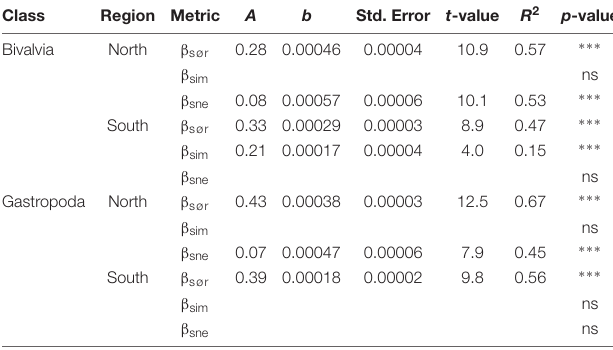
TABLE 2 | Results from linear least squares regression models of Baselga (2010, 2012) pairwise β -diversity metrics as a function of depth separation between 300 and 1600